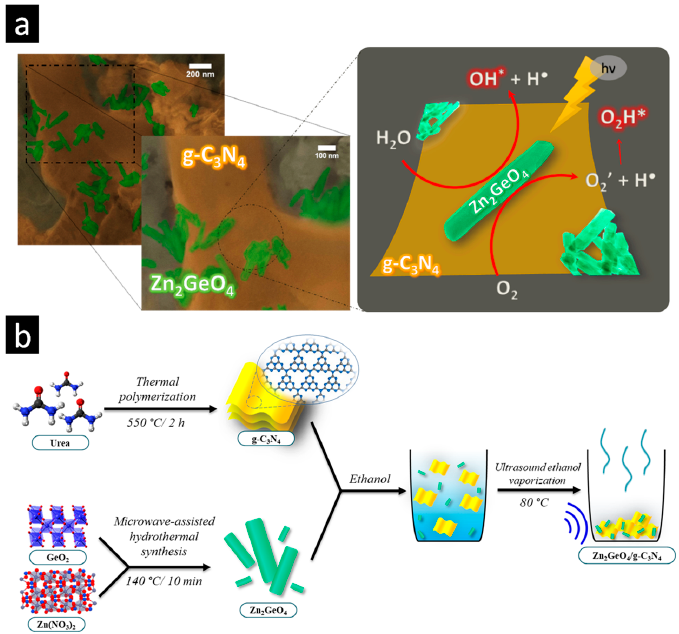
Figure 5. ( a ) SEM images and the tentative photocatalytic degradation mechanism over Zn 2 GeO 4 /g- C 3 N 4 nanocomposites. ( b ) Scheme of Zn 2 GeO 4 , g-C 3 N 4 and Zn 2 GeO 4 /g-C 3 N 4 composite